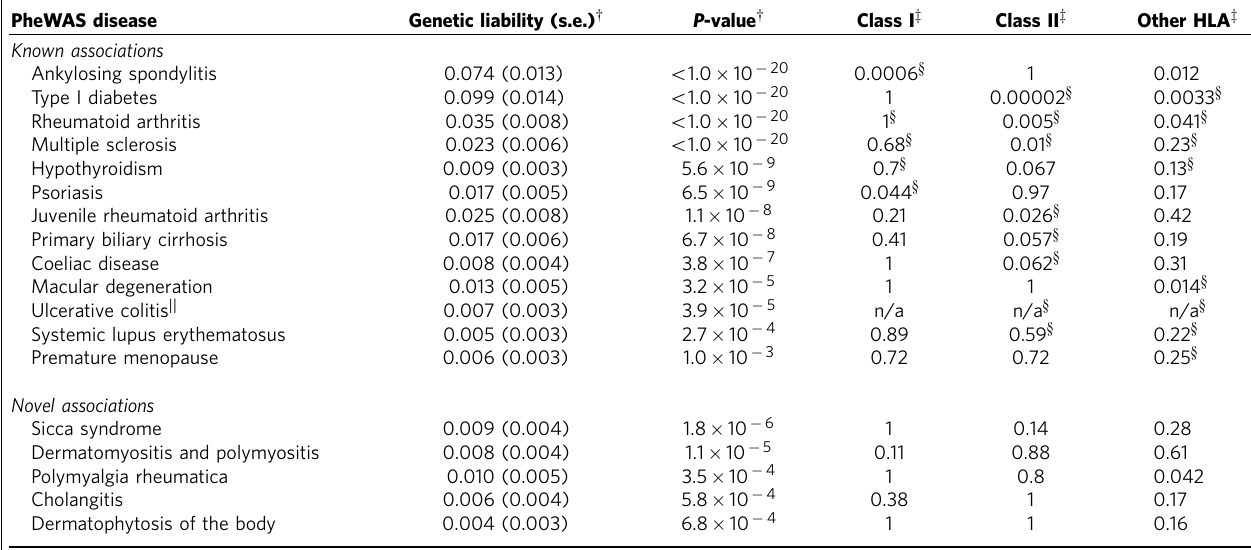
Table 1 | PheWAS phenotypes associated with SNP variation in the HLA region*. PheWAS